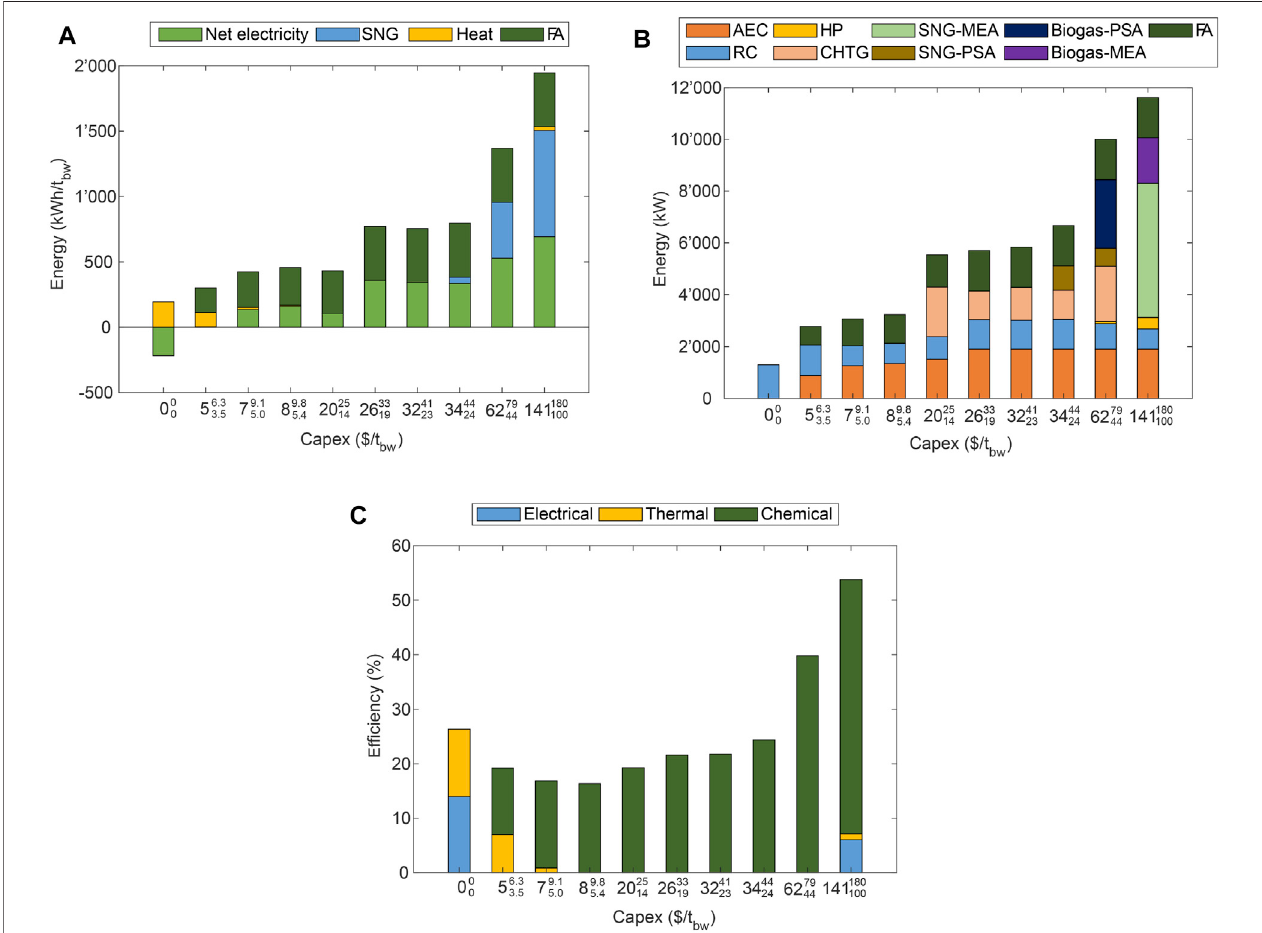
FIGURE 5| System con fi gurations, highlighting (A) energy fl ows, (B) technology activation and (C) ef fi ciencies asa function of Capex: centralvalue represents the average, whereas sub- and superscript represent the 95% CI.